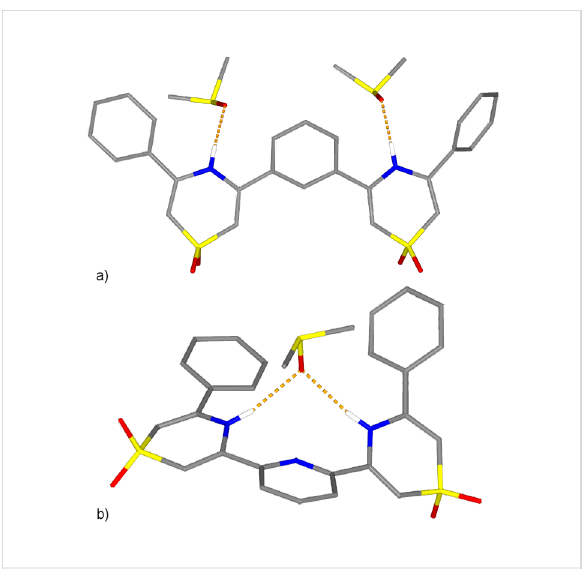
Figure 3: Stick representations of the X-ray crystal structures of (a) receptor 1 and (b) receptor 2 . Non-acidic hydrogen atoms omitted for clarity. Red = oxygen, blue = nitrogen, yellow = sulfur, grey = carbon. Hydrogen bonds denoted by dotted orange lines.